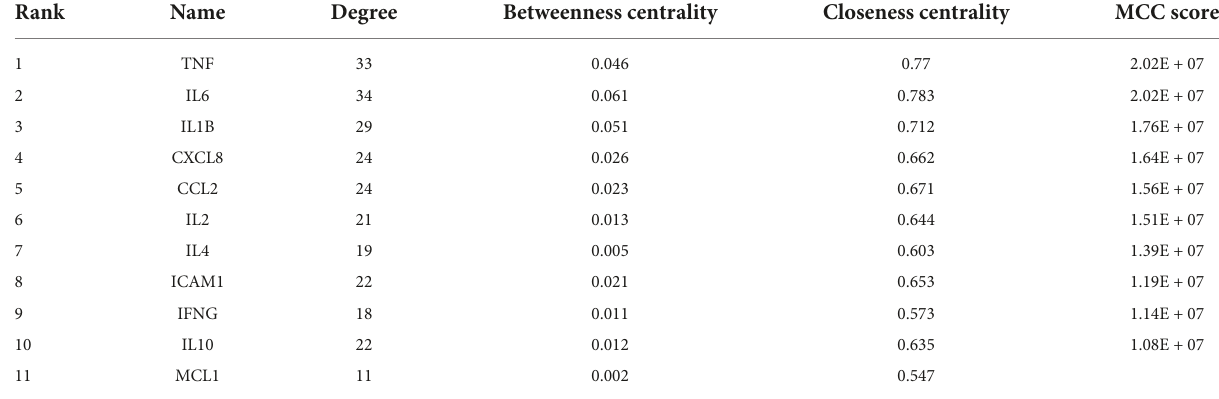
A total of 396 GO-BPs, 55 GO-MFs, and 33 GO- CCs were enriched by R package (version 3.6.3). The top 20 GO terms according to P -values < 0.05 are shown in Figure 5 . BP was mainly enriched in the regulation of the apoptosis process (5 in total), response to oxidative stress (3 in total), response to lipopolysaccharide (2 in total), response to molecules of bacterial origin (2 in total), inflammatory response, T cell activation and so on (see Figure 5A for details); CC was mainly concentrated in membrane rafts, membrane microdomains, membrane regions, mitochondrial outer membranes, organelle outer membranes, outer membranes, plasma membrane rafts, RNA polymerase II transcription factor complexes, cell-substrate adherens junctions, cell-substrate junctions and so on, and the membrane had the largest proportion (see Figure 5C ); MF was mostly involved in inflammatory mediator cytokines, MAP kinase activity, phosphatase binding, heme binding, and so on (see Figure 5B ).